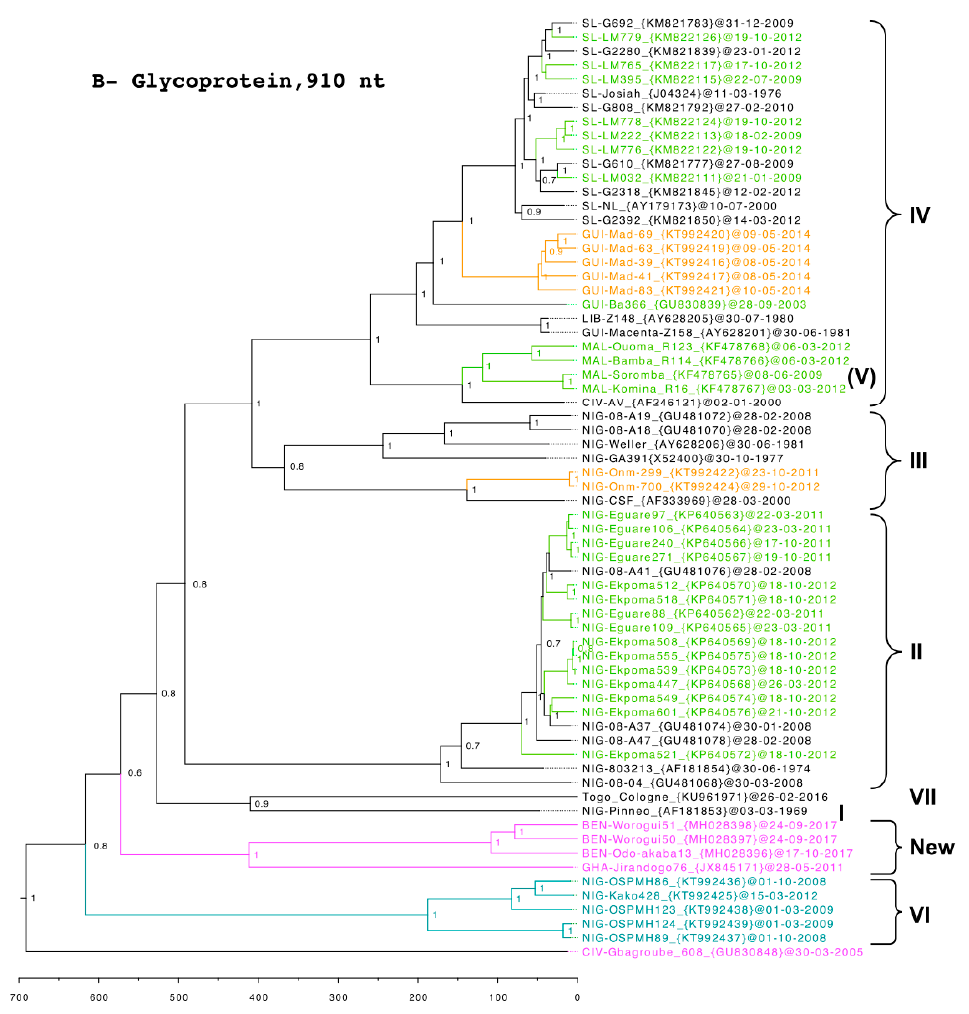
Figure 3. Time-calibrated phylogenetic analysis of LASV in humans (in black), Mastomys natalensis (in green), Mastomys erythroleucus (in orange), Hylomyscus pamfi (in blue), and Mus baoulei (in pink). The tree is rooted with the Gbagroube virus found in Mus setulosus (in pink). Statistical support of grouping from Bayesian posterior probabilities is indicated at the node. Country, strain name, GenBank accession numbers, and day of collection are indicated on the labels. Scale bar indicates time in years. The analysis was inferred by using the Bayesian Markov Chain Monte Carlo (MCMC) method implemented in BEAST software [48]. The following settings were used: GTR + gamma with codon partition 1,2,3, strict clock and constant population. MCMC chains were run for 10 million states and sampled every 10,000 states to obtain an e ff ective sample size above 200 for all the parameters. ( A ) The tree is based on the complete nucleoprotein NP gene (1710 nucleotides), including 48 taxa. ( B ) The tree is based on the partial glycoprotein GP gene (910 nucleotides), including 67 taxa, in particular those from M. natalensis in the Edo state and those from H. pamfi in the Osun state. Sequences used for these analyses were published in [5,12,24,28,29,45,46,49–54] as well as in Jahrling et al., Direct Submission,